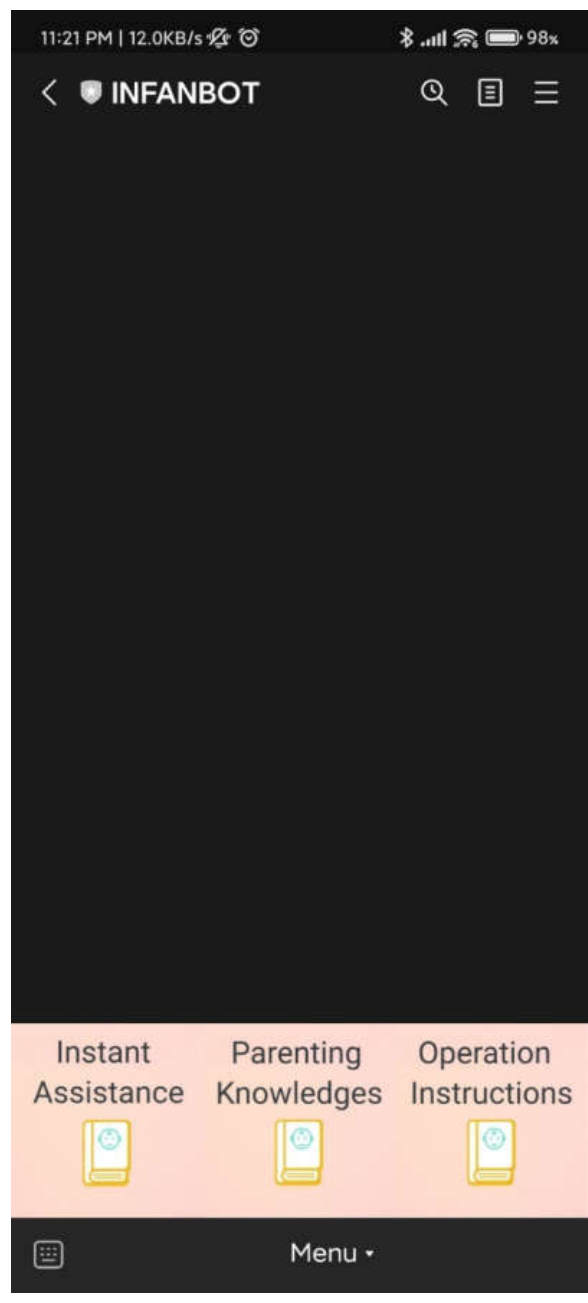
Figure 3. The INFANBOT menu on the mobile phone.